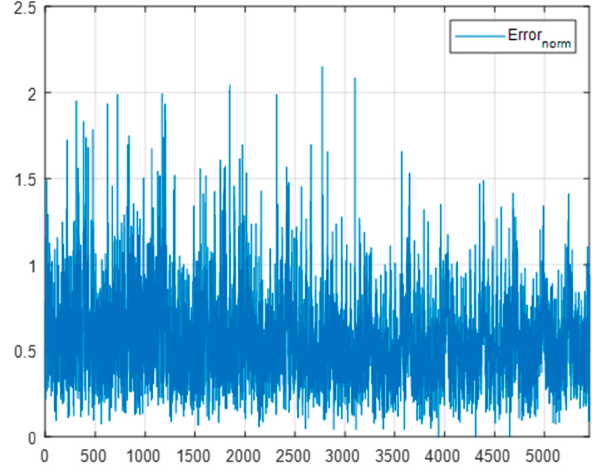
Figure 24. Measurement error.